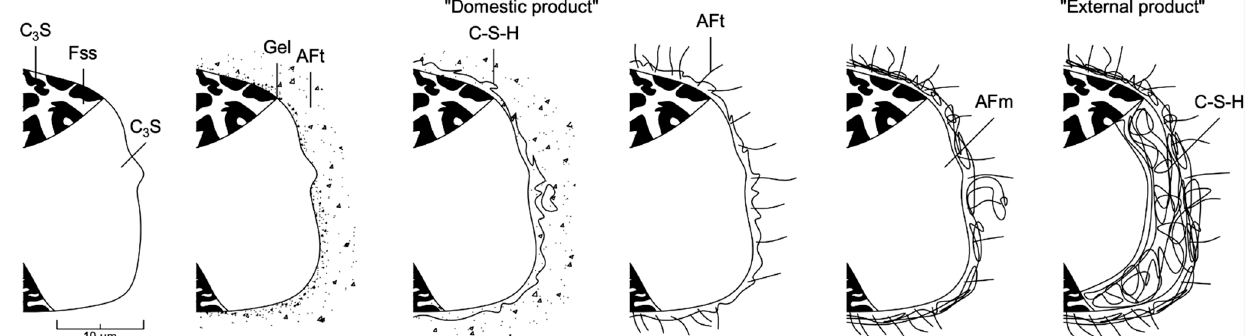
Figure 7. Development of the microstructure of cement stone in the process of hydration of Portland cement, where: Fss—calcium aluminoferrite; AFt—calcium hydrosulfoaluminate; AFm—calcium hydrosulfoaluminoferrite.